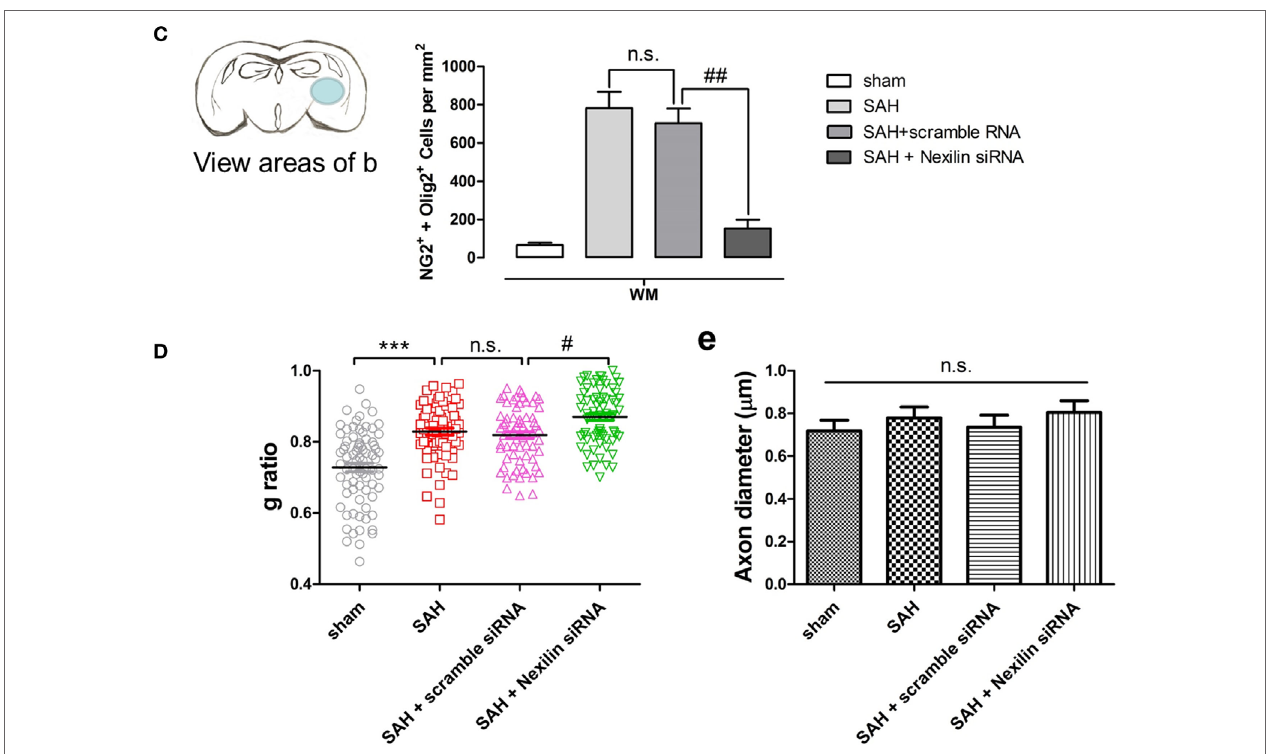
FigUre 3 | Genetic inhibition of nexilin impedes oligodendrocyte progenitor cell migration and remyelination after SAH. (a) Western blot analysis of nexilin and GAPDH in white matter (WM) at 3 days after SAH. The statistics histograms are shown on the right, n = 3 for each group. (B) Representative images of NG2/ nexilin- and NG2/Olig2-positive cells and the myelin ultrastructure at 3 days after SAH are shown. (c) Statistics of double-positive NG2 and Olig2 cells in WM of mouse brains at 3 days after SAH, n = 3 for each group. (D) G-ratios representing the myelin thickness based on the TEM images, n ≥ 60 for each group. (e) Statistical histogram of the axon diameter (micrometer) of myelin based on the TEM images, n ≥ 60 for each group. The data are presented as the mean ± SEM; *** P < 0.001 versus the sham group, # P < 0.05 versus SAH + scramble siRNA group, ## P < 0.01 versus SAH + scramble siRNA group, n.s. indicates no significance. SAH, subarachnoid